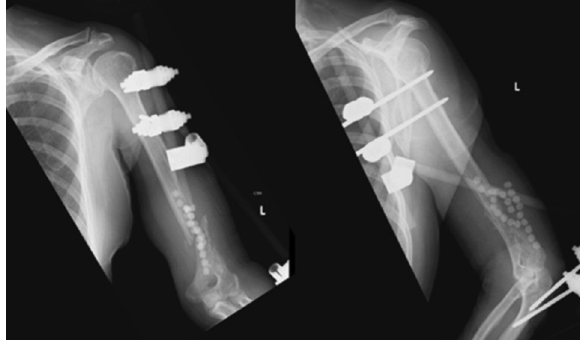
Post-operative radiographs with external fixator and Fig. 2: antibiotic beads.